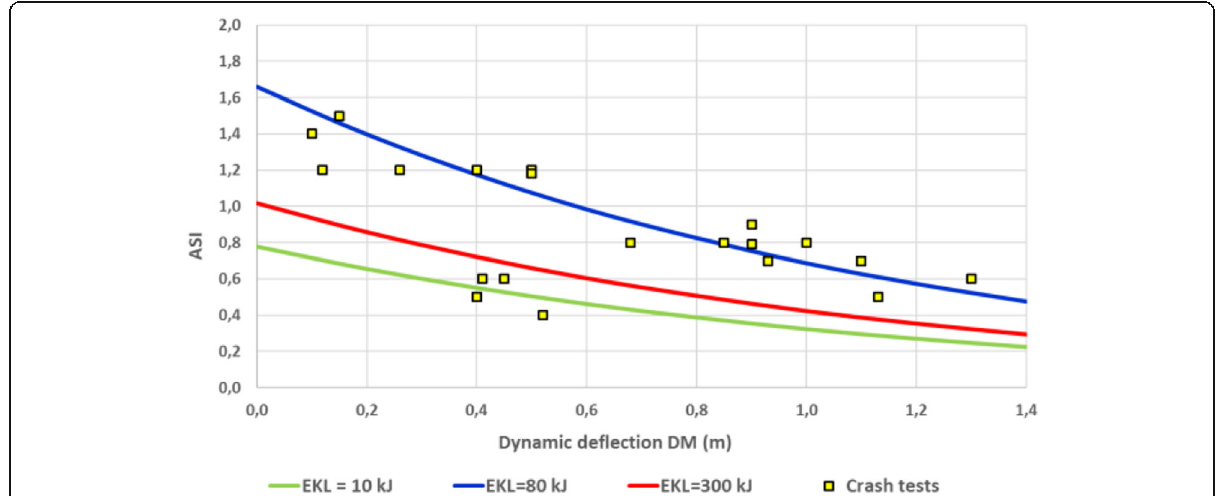
Fig. 10 Relationship between crash intensity ASI and barrier dynamic deflection DM and lateral kinetic energy of a vehicle hitting a barrier EKL overlaid with the results of site tests and simulation